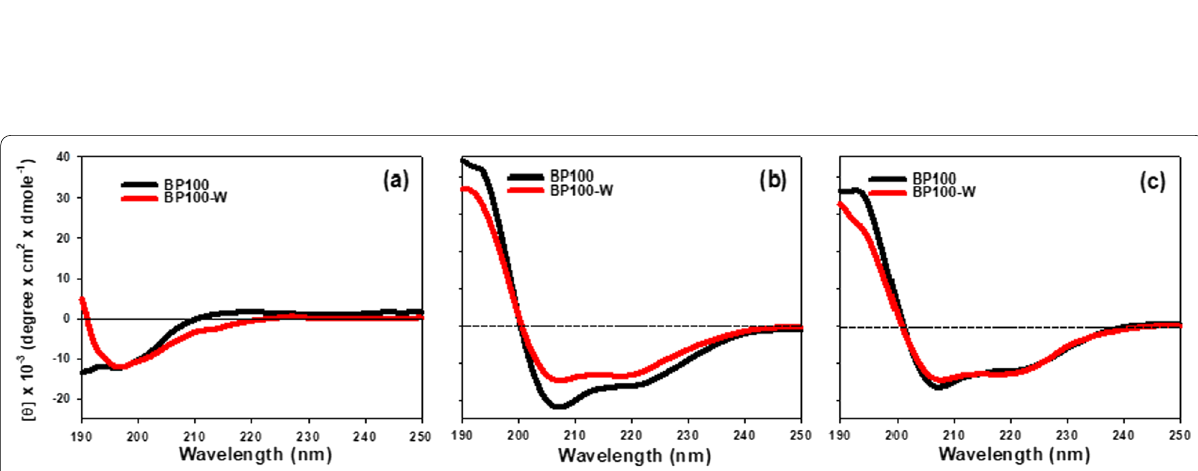
Fig. 3 Circular dichroism (CD) spectra of BP100 and BP100-W in the presence of 10 mM sodium phosphate buffer (pH 7.4) ( a ), 50% TFE ( b ), and 30 mM sodium dodecyl sulfate (SDS) ( c